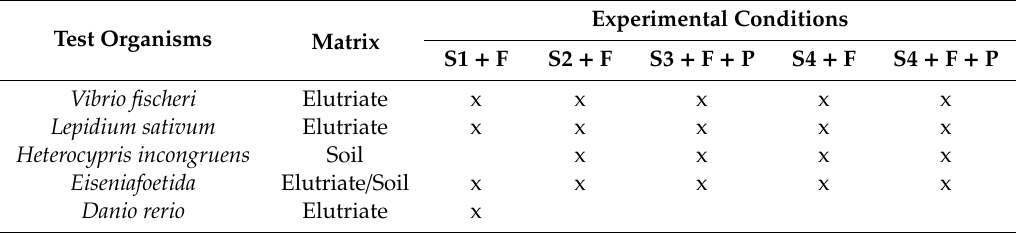
Table 3. Lists of organisms used for performing tests on conditioned soils and corresponding